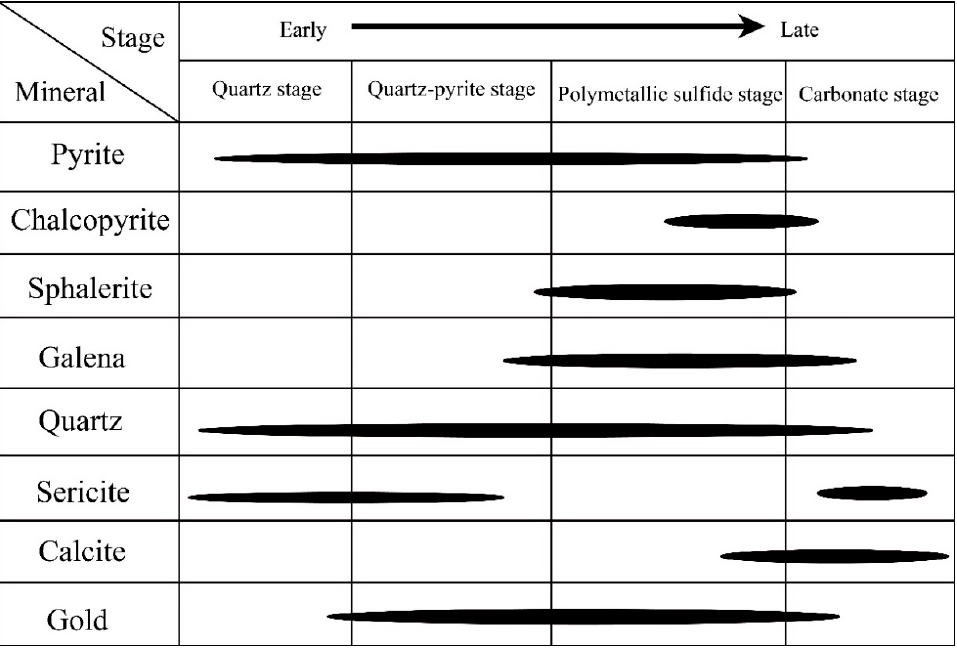
Figure 5. Mineral paragenetic sequence of the Fang’an gold deposit based on petrographic and BSE observations, as well as LA-ICPMS mapping.